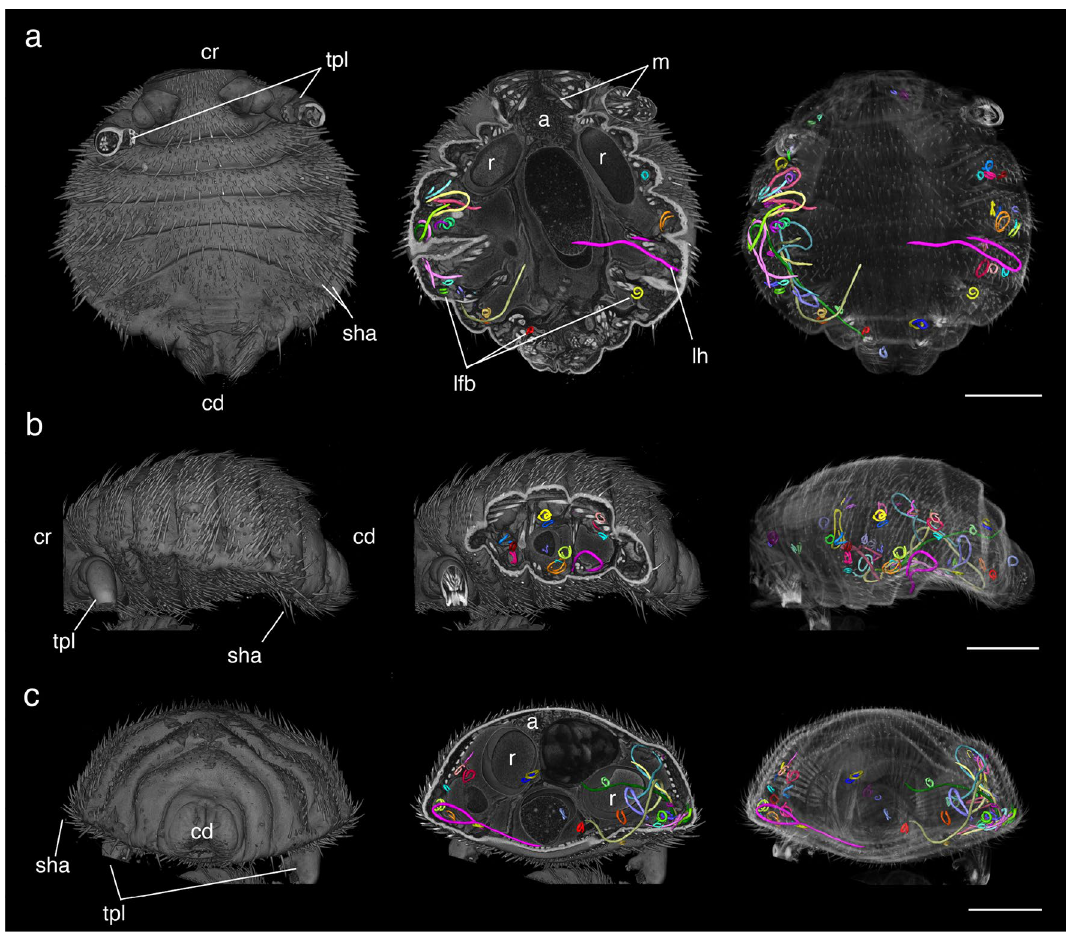
Figure 2. X-ray microCT imaging analysis and 3D reconstruction of Echinophthirius horridus , with various Acanthocheilonema spirocauda larvae (colored, string to sausage-shaped structures) in different body layers. In situ visualization. ( a ) Ventral view. ( b ) Lateral view ( c ). Caudal view. Scale bars: 500 µm. Abbreviations: a = alimentary tract, cd = caudal, cr = cranial, lfb = larvae contorted in the fat body, lh = larvae located in the haemocoel, m = musculature, r = reproductive tract (nits/eggs), sha = setae modified to hairs, tpl = third pair of